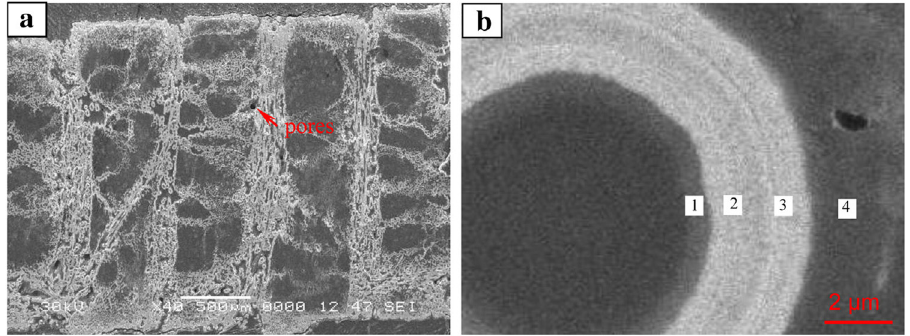
Figure 2: Microstructures of C f /C – TaC composites: ( a ) microstructure ( SEM ) and ( b ) PyC/C – TaC/PyC layered structure matrix ( SEM ) [ 47 ]